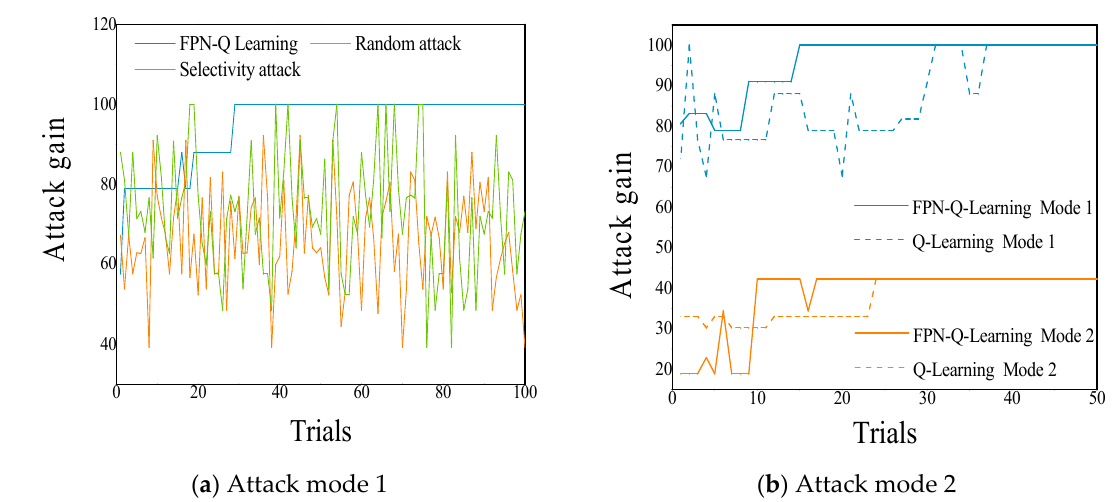
Figure 7. ( a ) Comparison with random attack and selective attack and ( b ) Comparison with unimproved Q-Learning algorithm